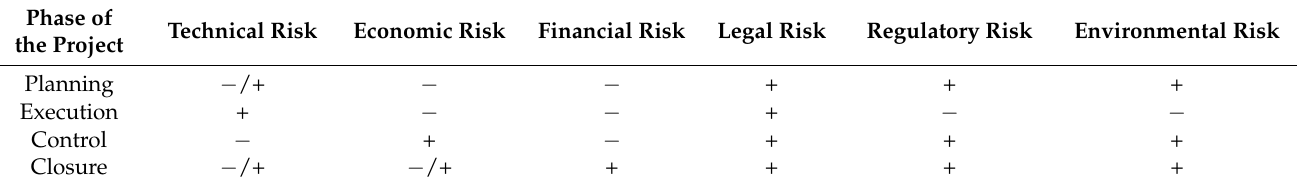
Table 5. Risks of CHP investment projects at the planning phase.